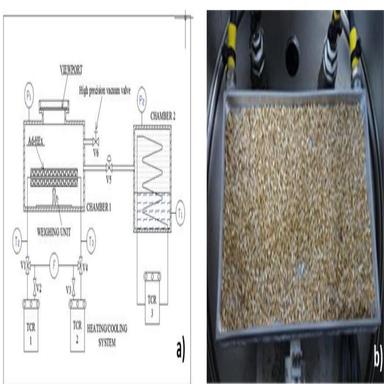
(a) Schematic layout of the G-LTJ apparatus; (b) view of the tested sorbent placed on an aluminium flat plate HEx (right).